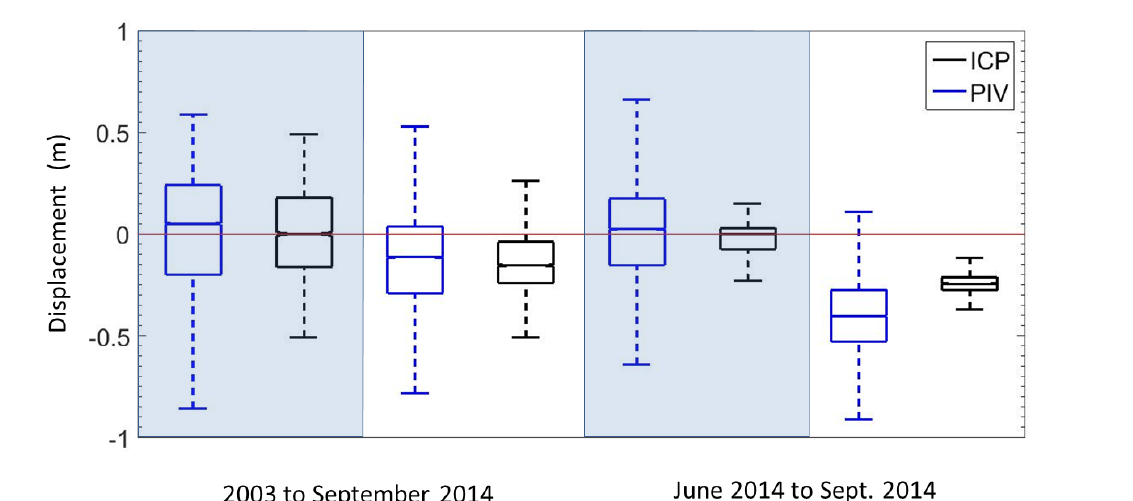
Figure 4. Box plots of ICP results and PIV results from geodetic marker point clouds, separated by points east and west of the main western fault trace over two temporal periods, 2003 to September 2014 and June 2014 to September 2014.